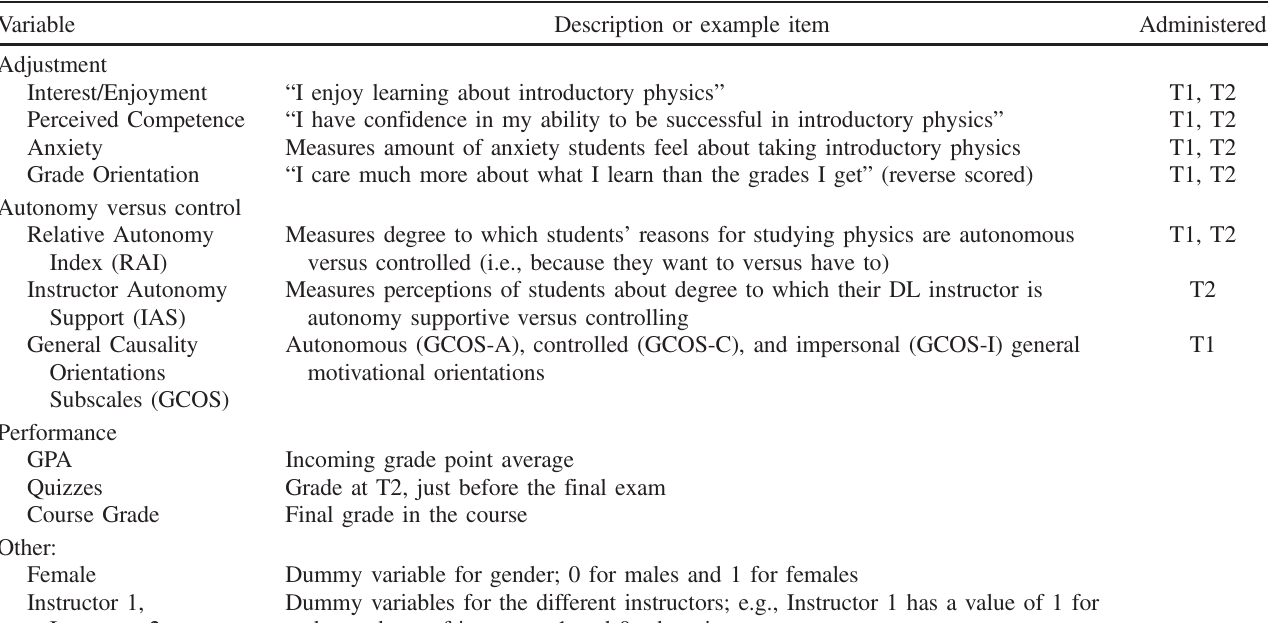
TABLE I. A summary description of key variables in this study. Variables are grouped by measure type. Also shown are variable name, either a description of the variable or an example item from the corresponding measure, and when the corresponding measure was administered to